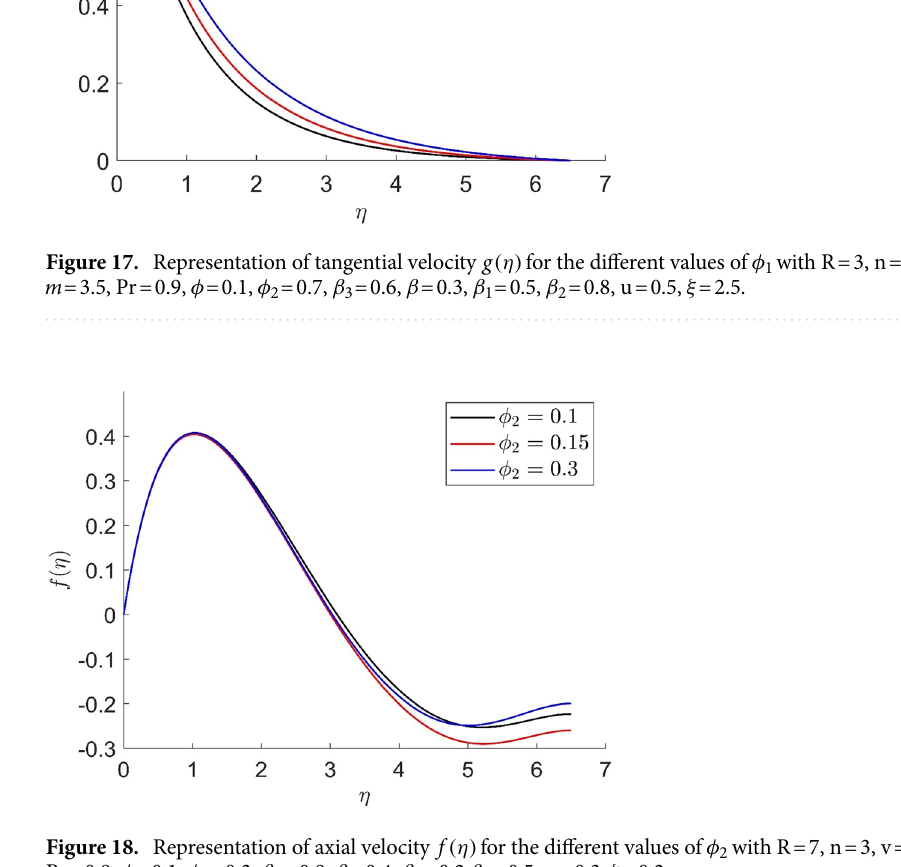
Figure 18. Representation of axial velocity f (η) for the different values of φ 2 with R = 7, n = 3, v = 0.2, m = 1.5, Pr = 0.9, φ = 0.1, φ 1 = 0.2, β 3 = 0.9, β = 0.4, β 1 = 0.2, β 2 = 0.5, u = 0.3, ξ = 0.2.